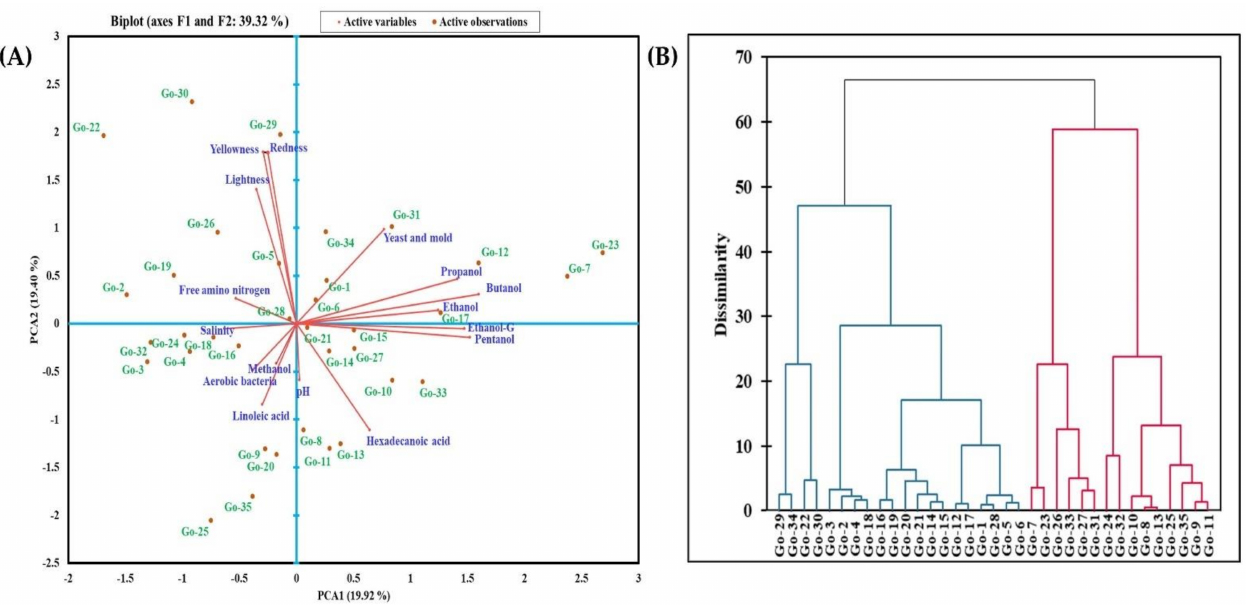
Figure 2. Principal component analysis ( A ) and agglomerative hierarchical clustering analysis ( B ) of 35 different gochujang products from the traditional cottage